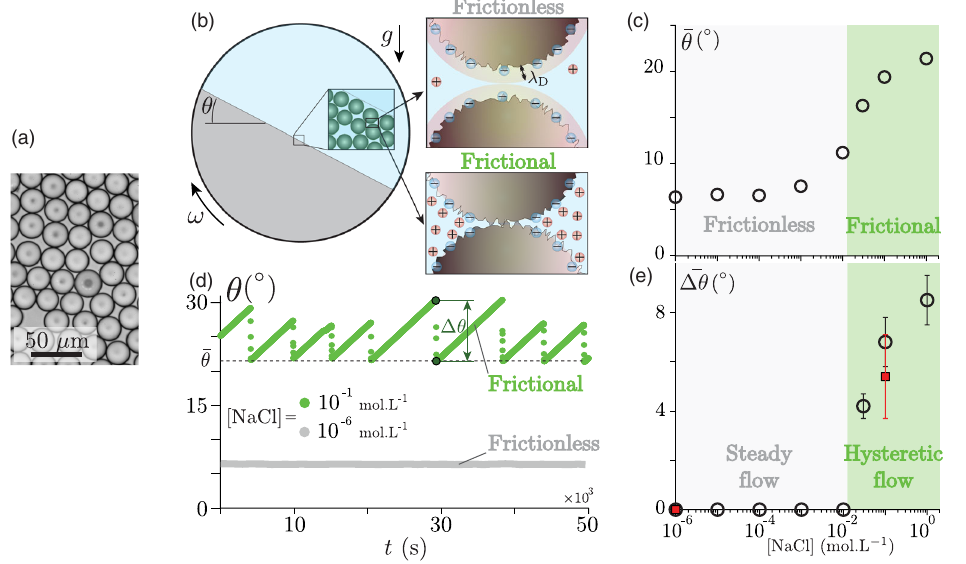
FIG. 2. Interparticle friction triggers hysteretic avalanches: (a) Picture of the silica particles ( d ¼ 23 . 46 (cid:2) 1 . 06 μ m, ¼ 1850 kg · m − 3 , St ¼ 2 × 10 − 2 ). (b) Schematic depicting how interparticle friction is tuned by varying the solvent ionic ρ p ¯ θ concentration. (c) Time-averaged avalanche angle versus ionic concentration [NaCl]. (d) Avalanche angle θ versus time for frictionless ¯ Δ θ (black) and frictional (green) particles. (e) Mean hysteresis amplitude (averaged over 15 avalanches) versus salt concentrations. Square markers correspond to experiments performed with a water/glycerol mixture (St ¼ 2 × 10 − 3 ). All measurements were performed for ω ¼ 10 − 3 ° · s − 1 except for the water/glycerol mixture where ω ¼ 10 − 4 ° · s − 1